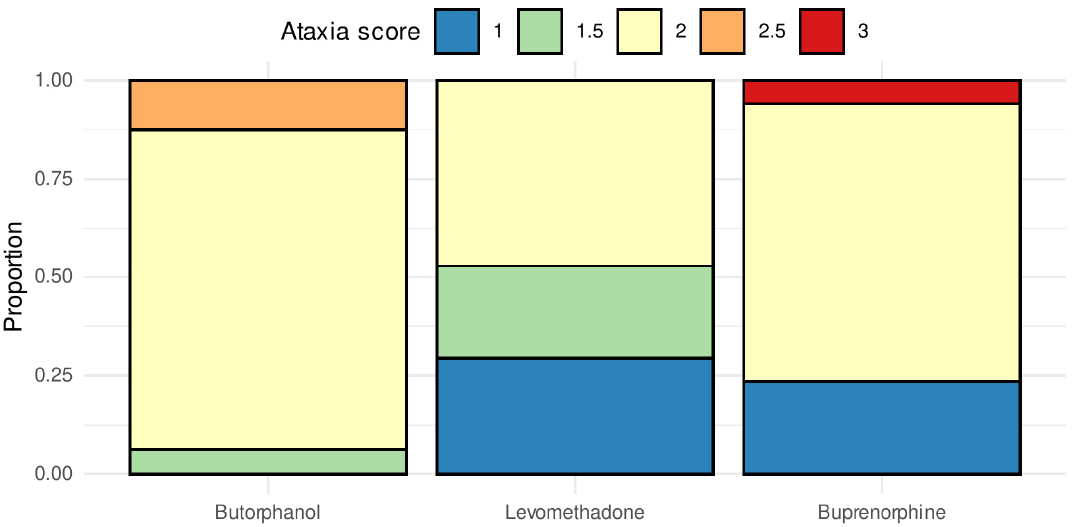
Figure 1. Score of ataxia. Comparison of ataxia according to the used sedation score with a bar plot. Shown is the median of the assigned score values for each opioid on the X -axis. The Y -axis marks the proportion of horses out of the total number of patients who rated the corresponding median score (1 = mild ataxia; 3 = severe ataxia).